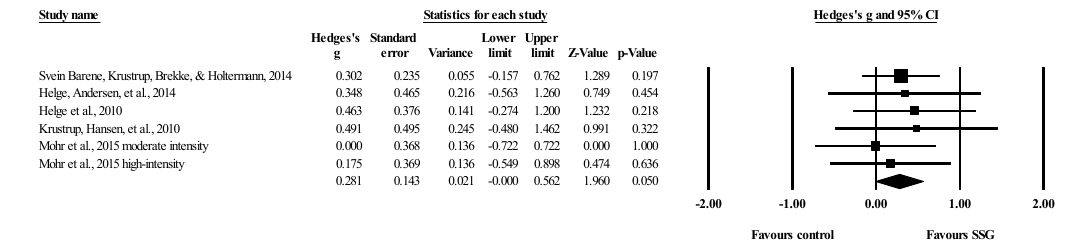
Figure 9. Funnel plot for changes in lower-body bone mineral density in untrained adults after a training program based on soccer small-sided games compared to a passive control condition. White circles: observed studies.